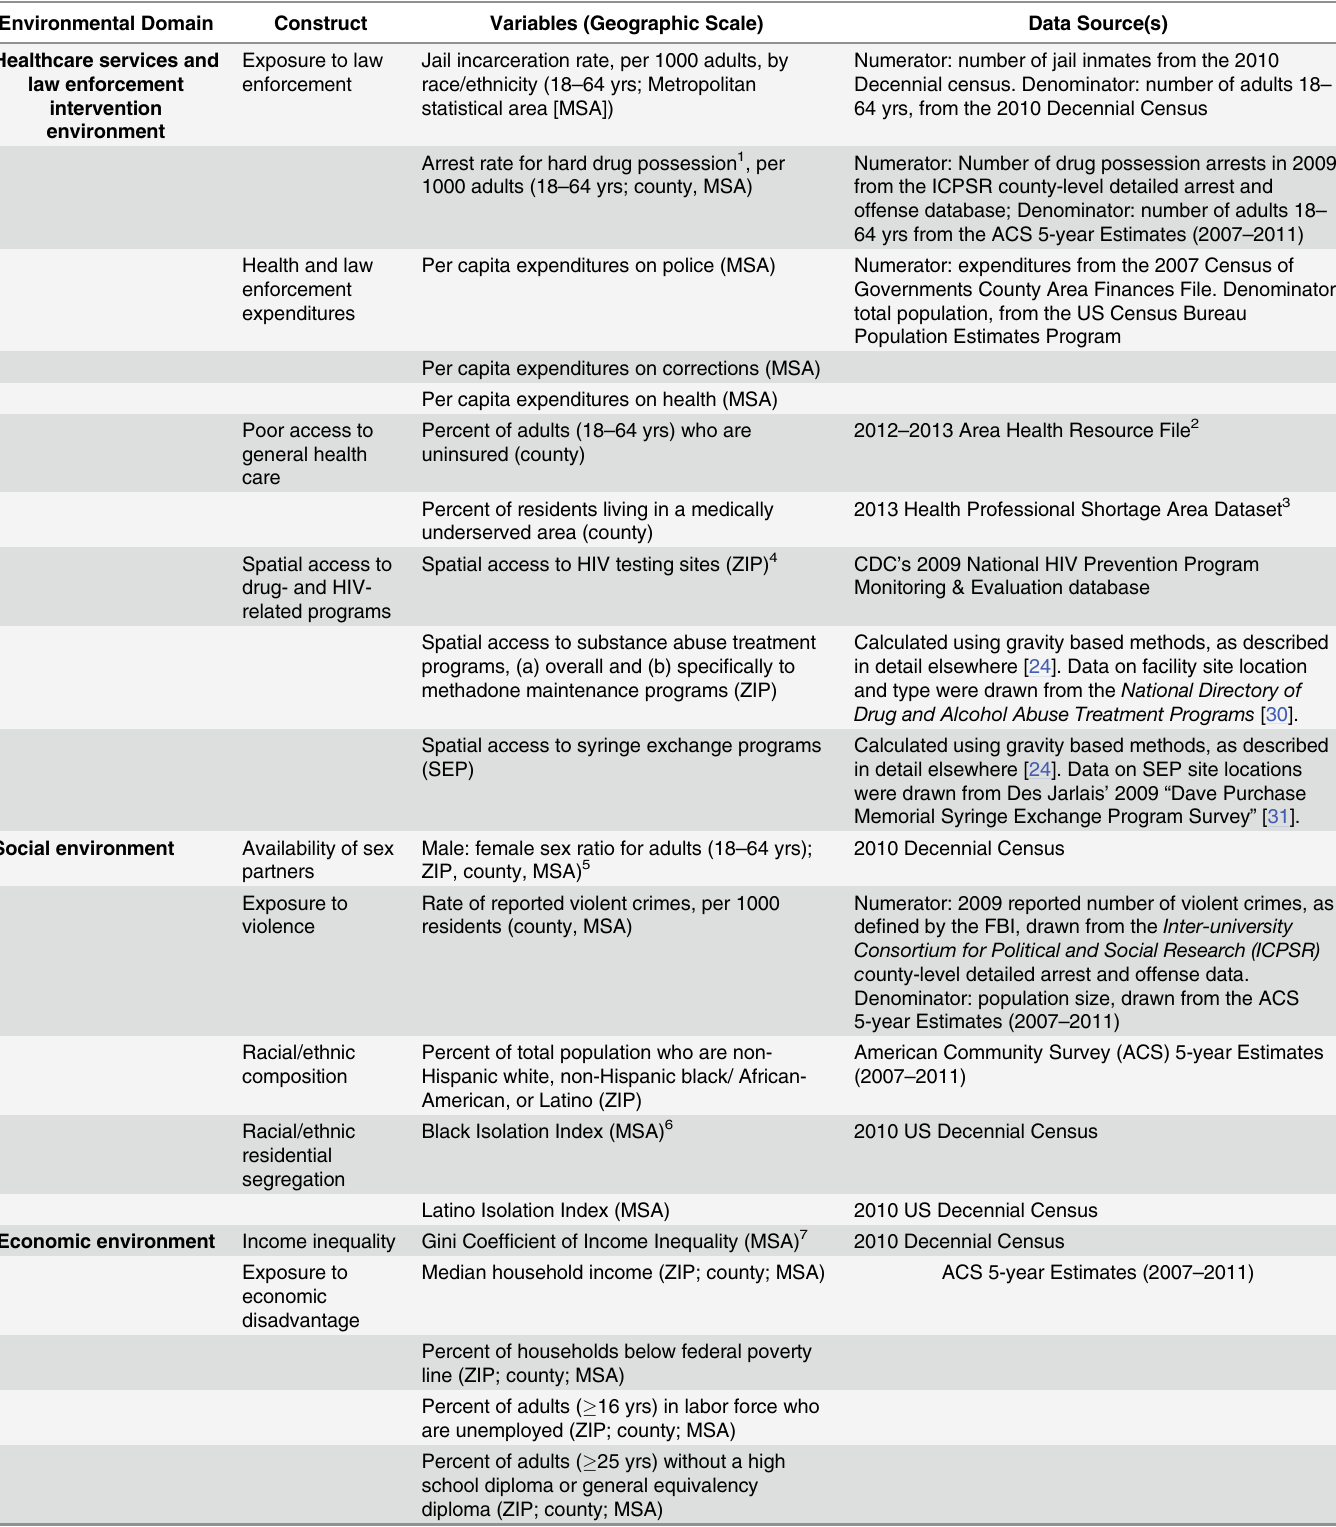
Table 1. Place-based Constructs, Variables, and Data